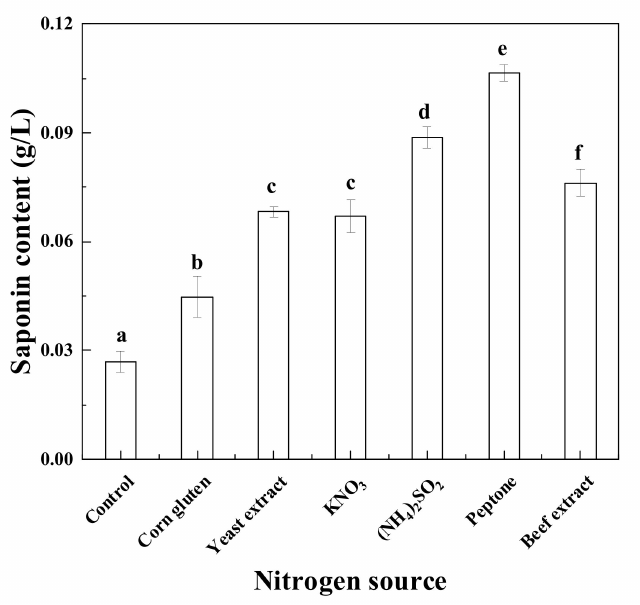
Figure 2. Effects of the nitrogen source on the saponin production of T. melanosporum . (Different letters on the top of column indicate significant differences between means: a, b, c, d, e, f, p <